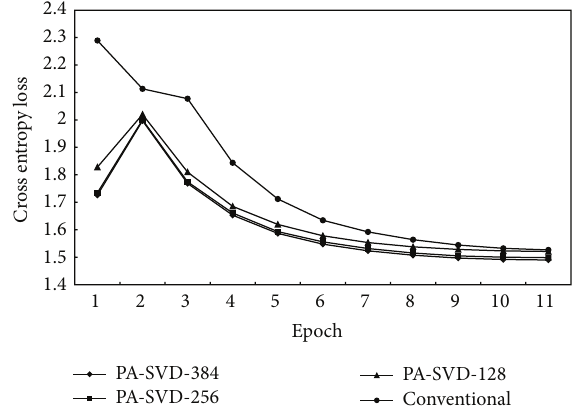
Figure 2: Cross entropy losses during the first epoch.